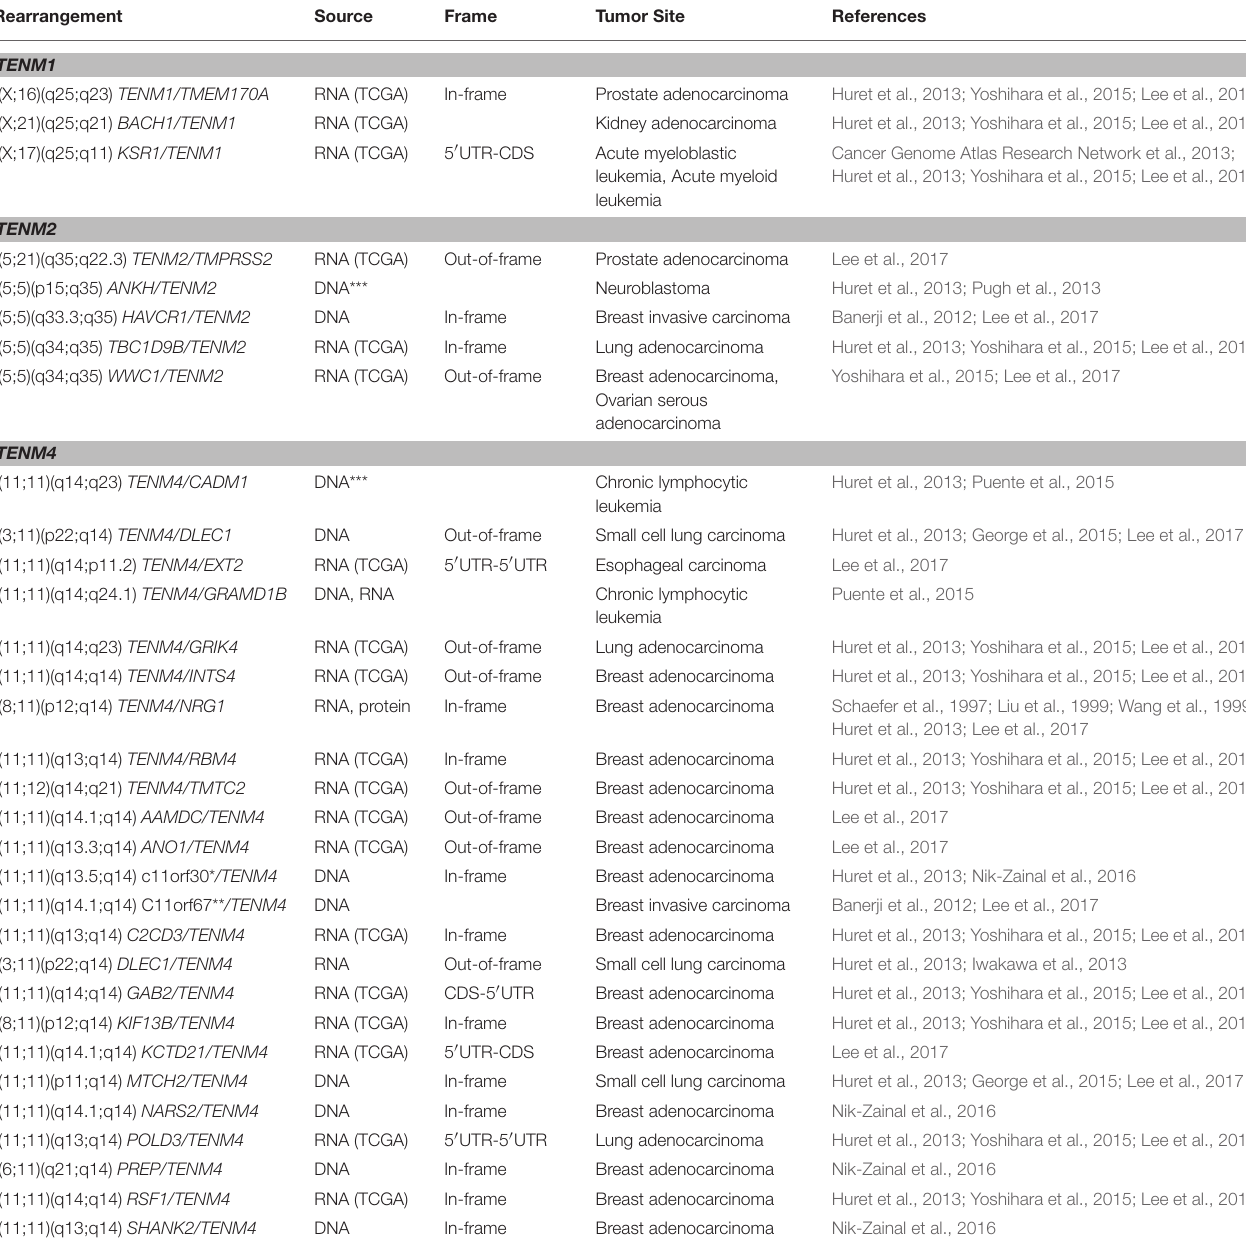
TABLE 1 | Reported tumor cytogenetic rearrangements involving Teneurin